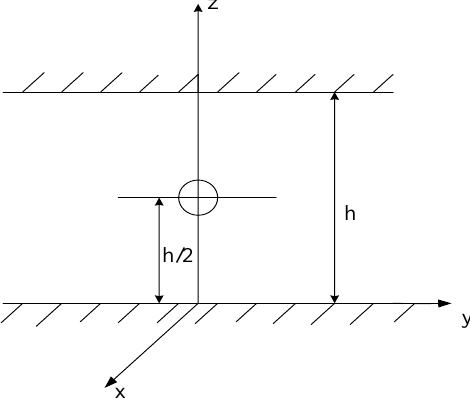
Figure 1—The horizontal well scheme of low permeability reservoir